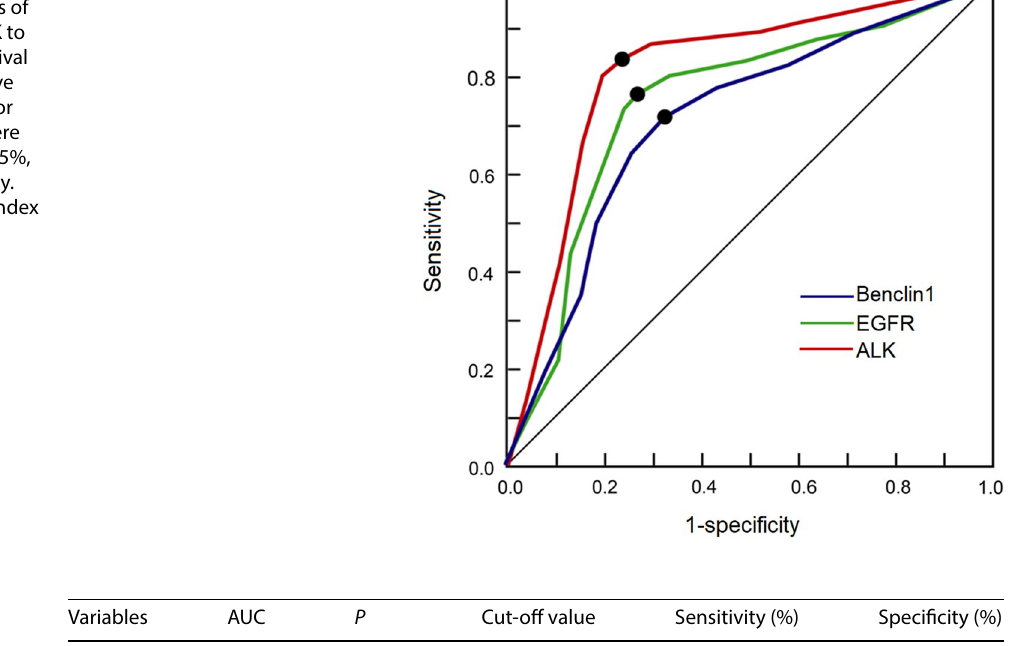
Fig. 3 Receiver operating characteristic (ROC) curves of Beclin level, EGFR and ALK to predict progress-free survival time. The areas under curve (AUC) and cut-off values for Beclin 1, EGFR and ALK were 0.812 and 1.2, 0.781 and 15%, 0.722 and 11% respectively. Dots denote the Youden index